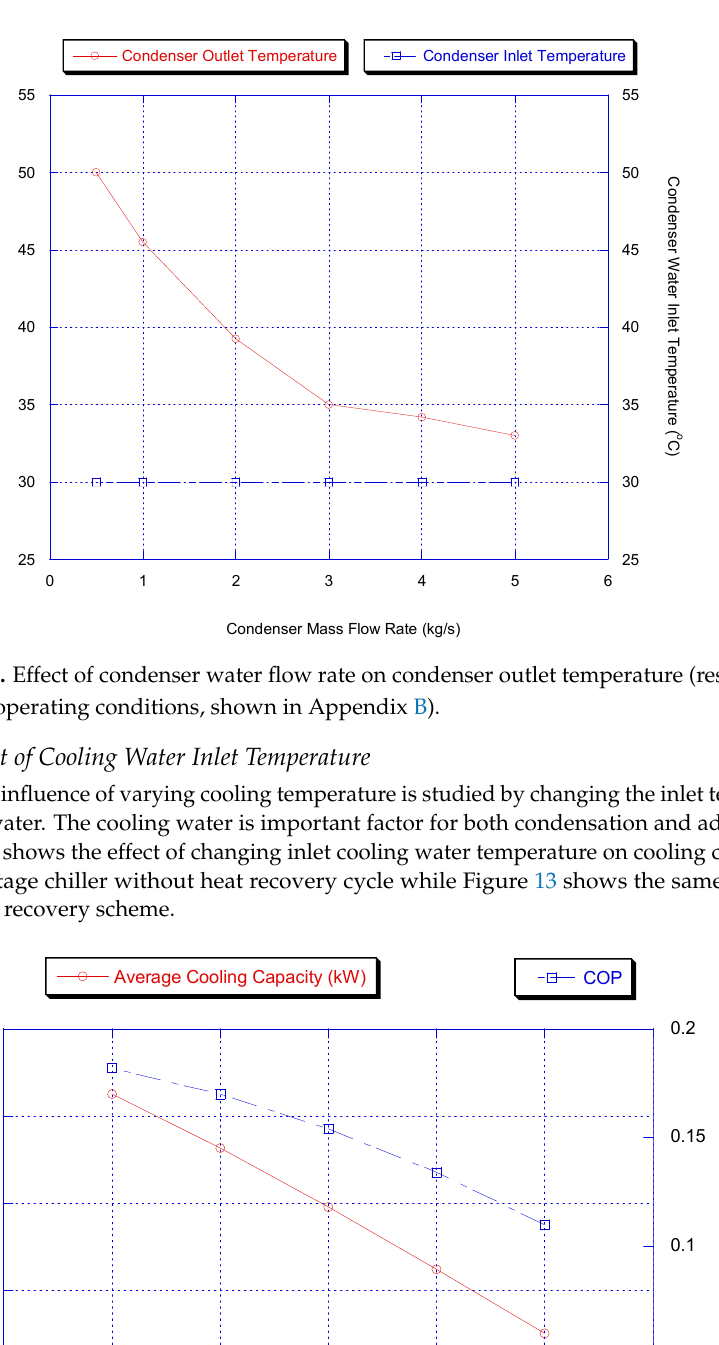
Figure 12. Effect of cooling water inlet temperature on chiller average cooling capacity and COP without heat recovery (results are at optimum parametric values, shown in Appendix B).